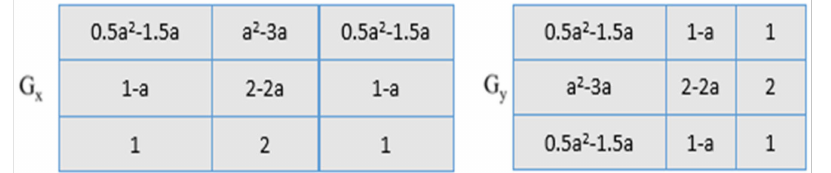
Figure 6. Left fractional-order Sobel.